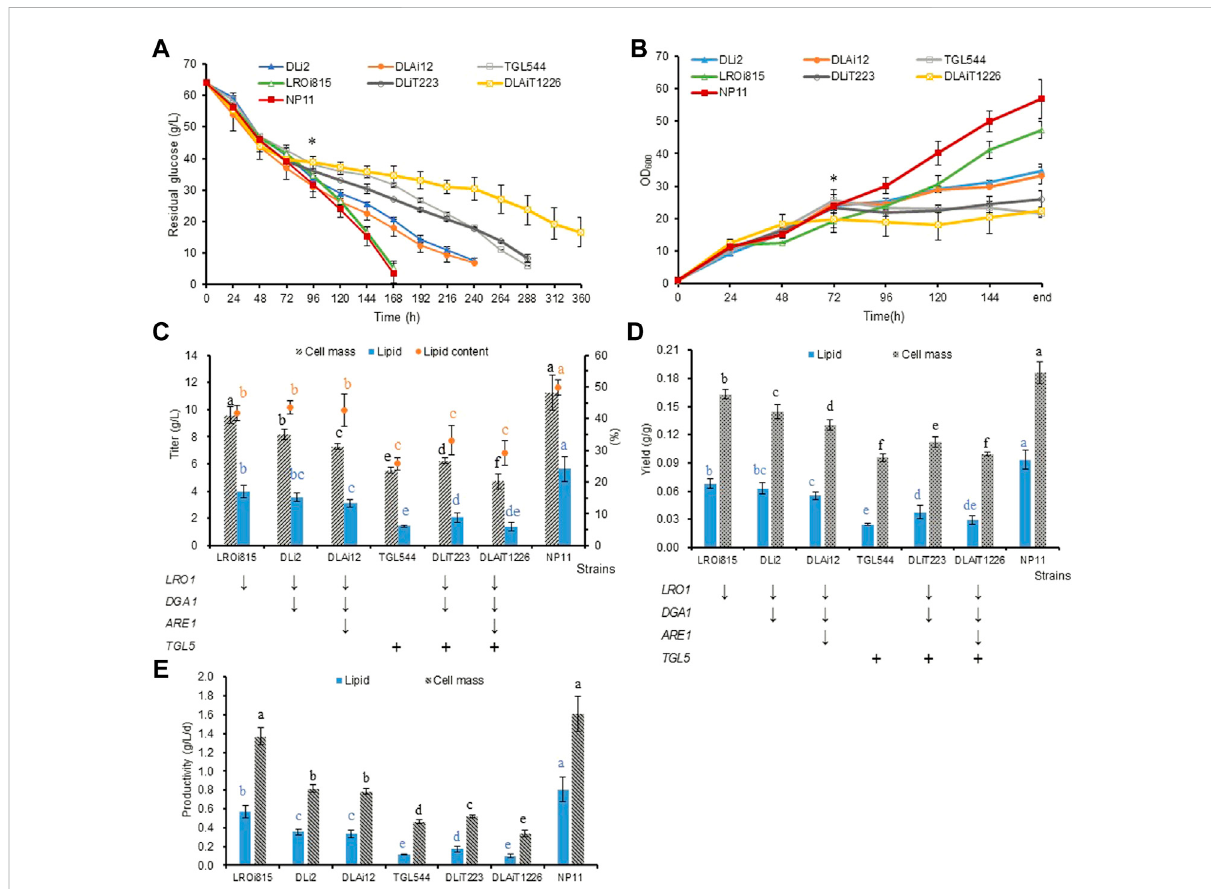
FIGURE 3 Lipid production pro fi les of R. toruloides variants under nitrogen limitation. (A) Pro fi les of glucose consumption. (B) Pro fi les of cell growth. End in Abscissa designated actual culture time of 168, 168, 240, 240, 288, 288, and 360 h for strains NP11, LROi815, DLi2, DLAi12, TGL544, DLiT223, and DLAiT1226,respectively,whichwereidenticaltothoseshownin (A) . (C) Resultsofcellmass,lipidtiter,andtotallipidcontents. (D) Resultsoflipidand cellmassyields. (E) Resultsoflipidandcellmassproductivity.Meanswithoutacommonsuperscriptletterandwith*differsigni fi cantly( p < 0.05) as analyzed by the one-way factor